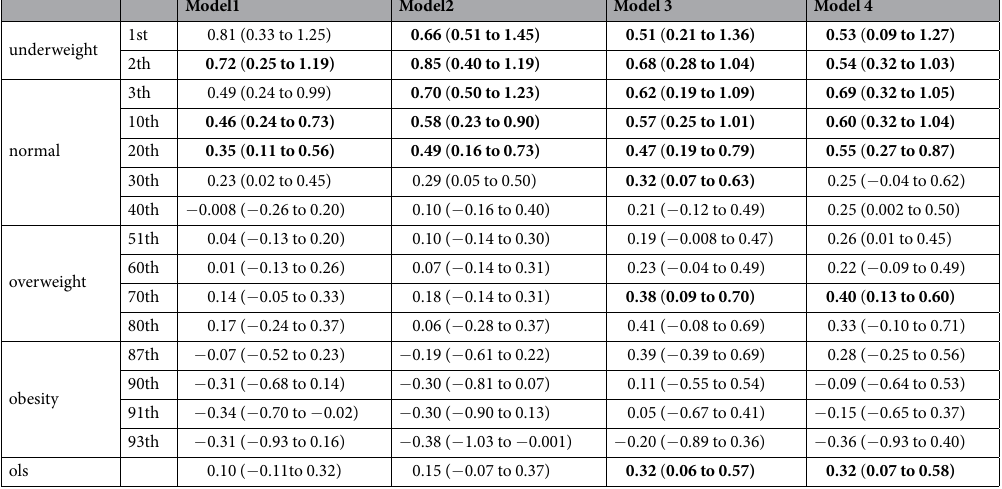
Table 3. Association between sufficient PA and BMI using QR and OLS models for different quantiles of BMI. Abbreviations: PA, physical activity; BMI, body mass index; CI, confidence interval; OLS, ordinary least squares; QR, quantile regression. Values are β estimates (95% CI). Coefficients and CI significant at the 5% level are in bold.